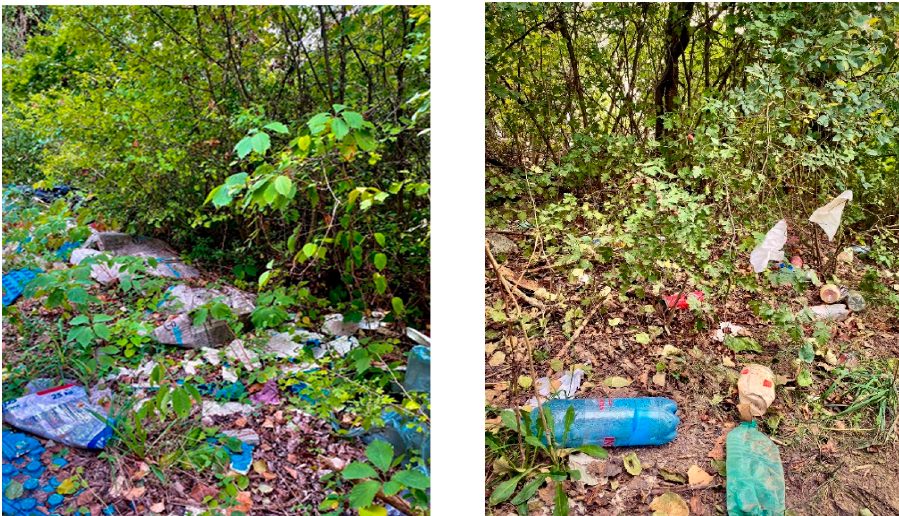
Figure 2. Sources of microplastic contamination (original photographs taken by the authors in isolated locations from Fortul I, Chitila 44 ◦ 29 (cid:48) 46 (cid:48)(cid:48) N 25 ◦ 59 (cid:48) 12 (cid:48)(cid:48) E in Romania on 17 September